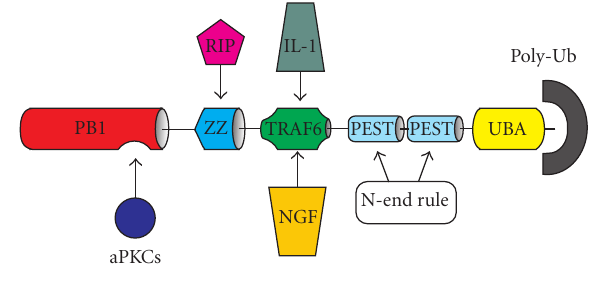
Figure 9: A schematic diagram showing the domain organization of p62